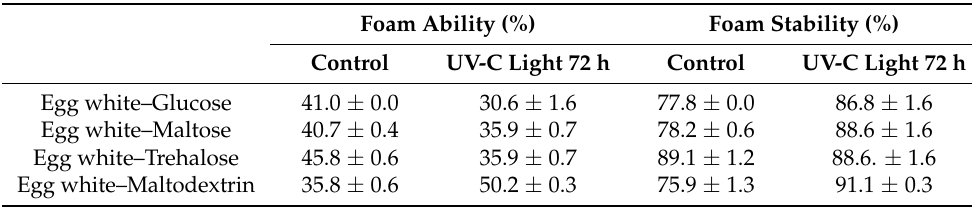
Figure 2. Gelling temperature of aqueous suspensions of egg white–sugar mixtures before and after exposure to UV-C light for 72 h. a–d : Means indicated by different letters are significantly different ( p < 0.05). Error bars represent the standard deviation. Table 4. Foam ability and stability (±standard deviation) of aqueous suspensions of egg white–sugar mixtures before and after exposure to UV-C light for 72 h.